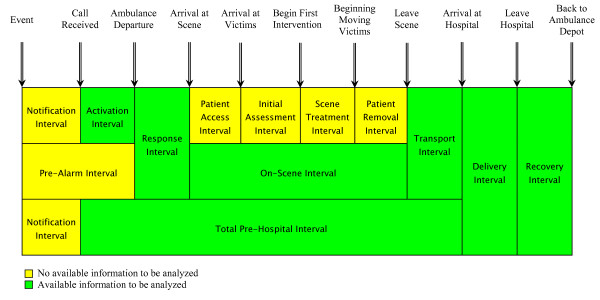
Specific intervals and points in time for road traffic injury victims. Adapted with some modification from references [15,25].